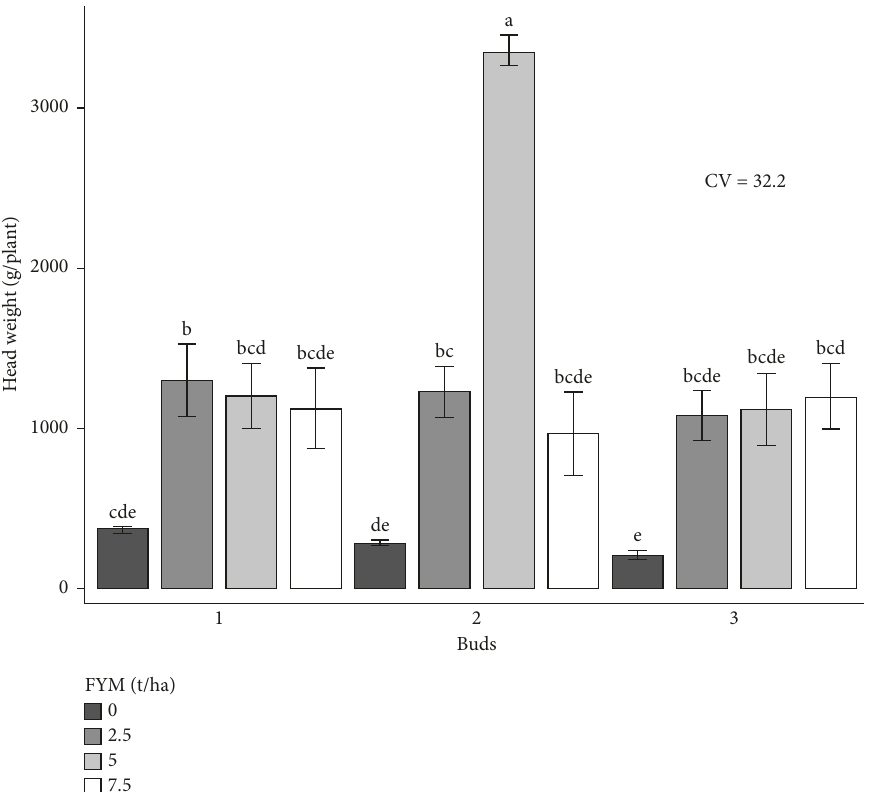
Figure 3: Head weight as influenced by the interaction effect of bud numbers and farmyard manure fertilizer